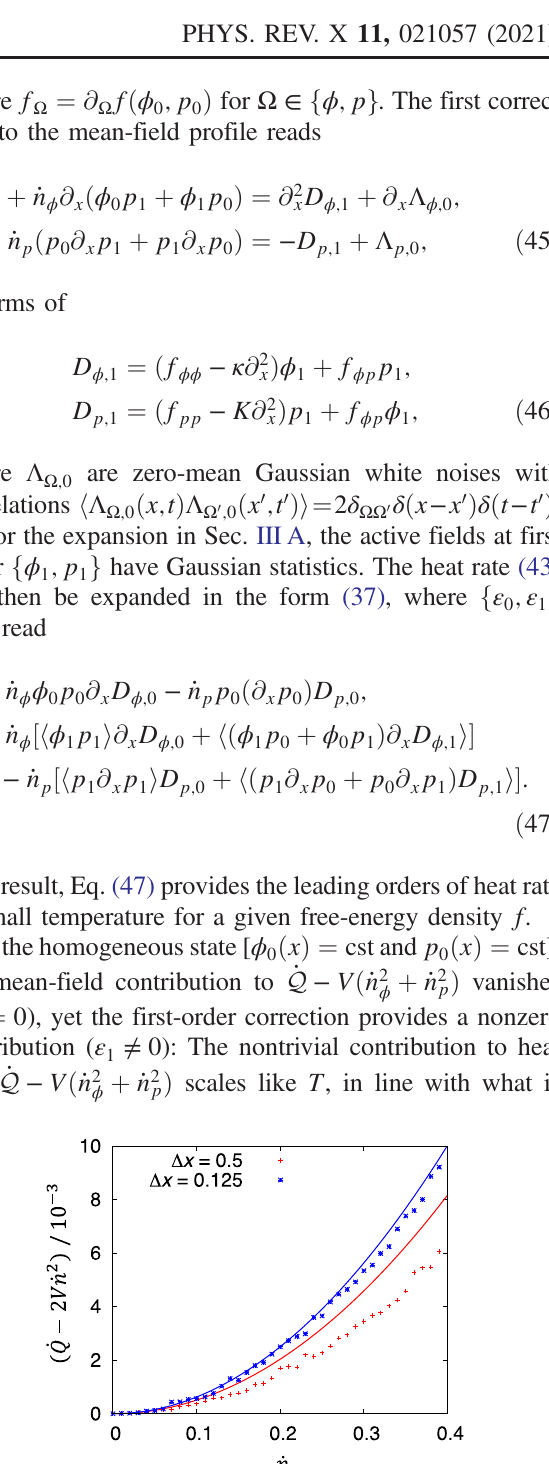
FIG. 4. In the absence of a droplet, namely, for homogeneous average profiles of density [ h ϕ ð x Þi ¼ cst] and polarization [ h p ð x Þi ¼ cst], the nontrivial contribution to heat rate 2 V _ n 2 scales like T 2 at small temperature T and as _ n 2 at small driving parameter _ n ϕ ¼ _ n p ≡ _ n . The numerical measurements get closer to our analytical predictions (C18), shown, respectively, in markers and solid lines, when the lattice spacing Δ x decreases, as expected. Simulation details are in Appendix D. Parameters: